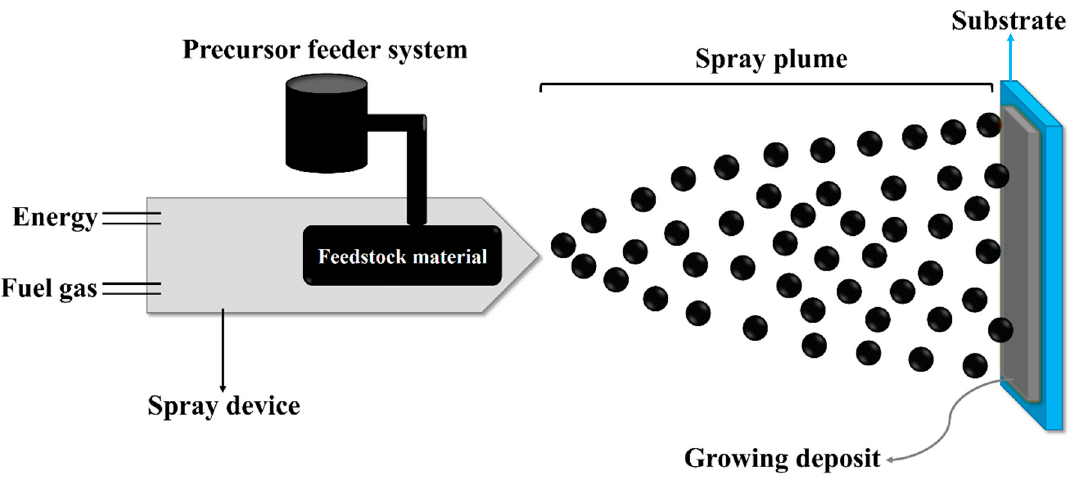
Figure 2. The schematic illustration of thermal spraying.